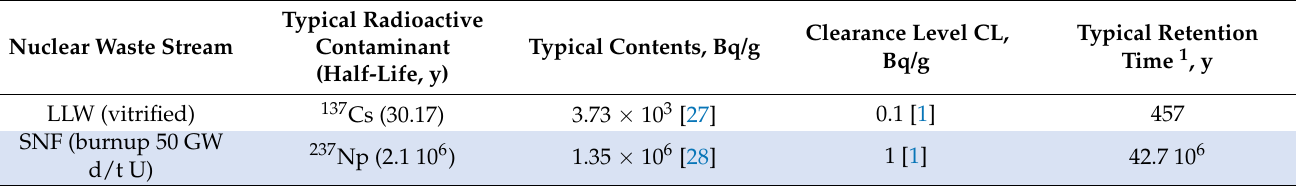
Table 2. Examples of typical retention times for LLW and SNF.